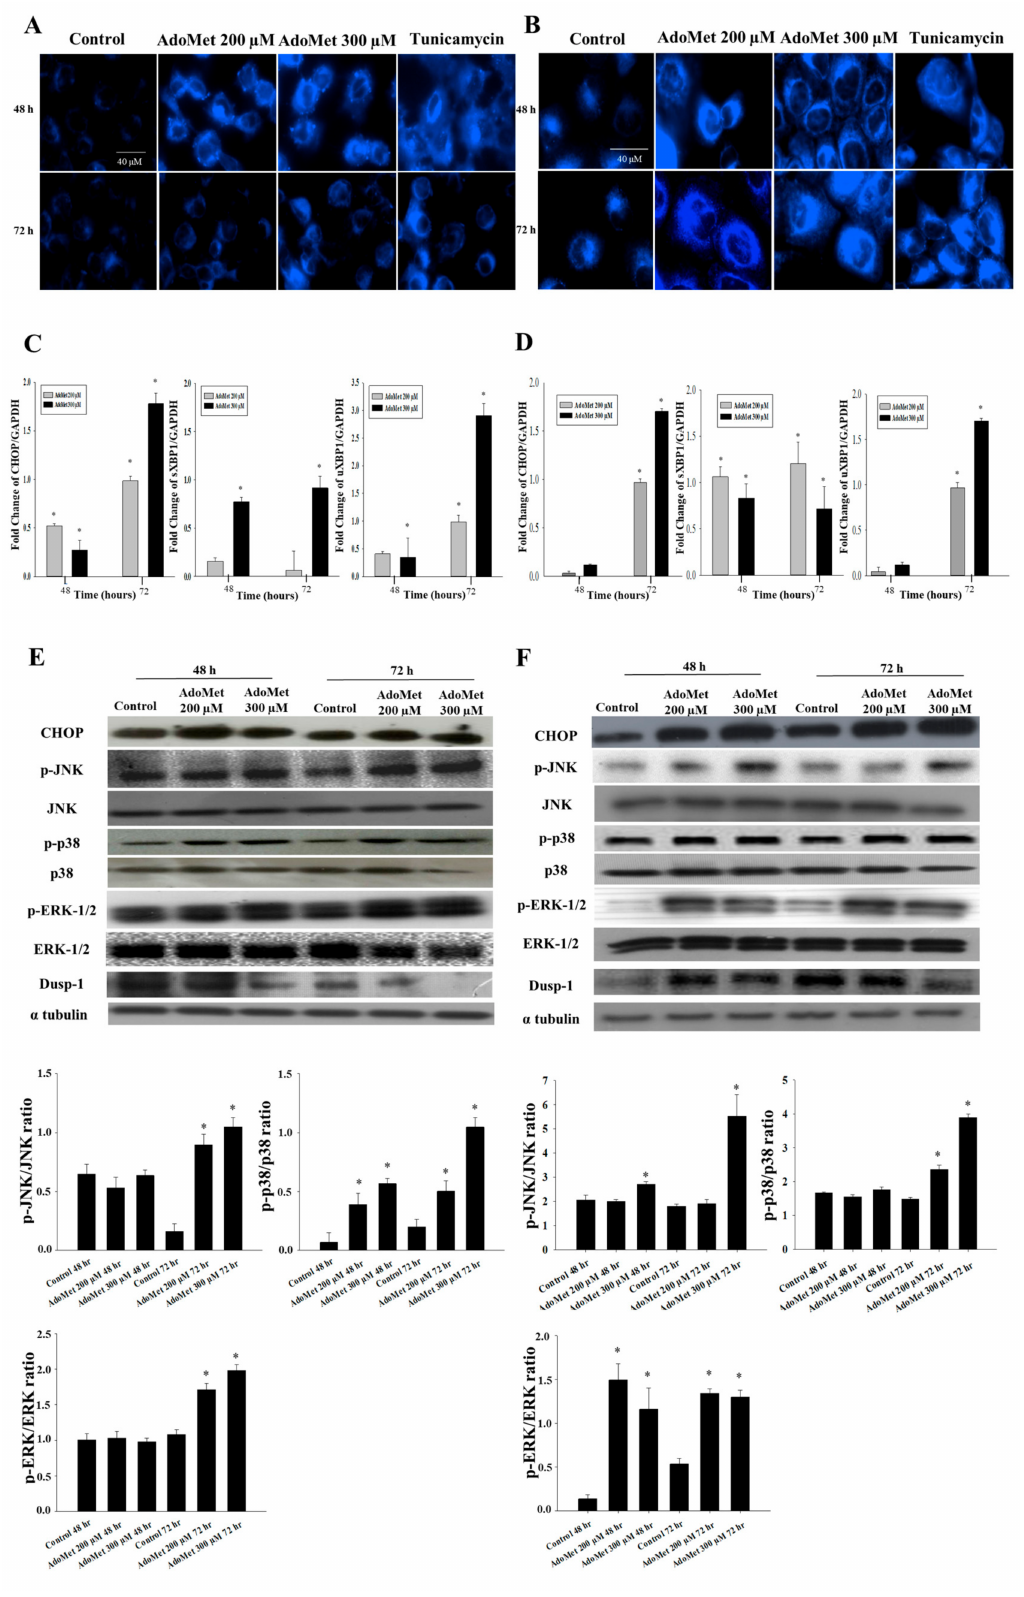
Figure 2. Effect of AdoMet on ER stress and related UPR in LSCC. ( A ) JHU-SCC-011 and ( B ) HNO210 cells were treated, or not (Control), with 200 and 300 µ M AdoMet for 48 and 72 h and then were incubated with ER-tracker and analyzed by fluorescence microscopy. Tunicamycin was used as positive